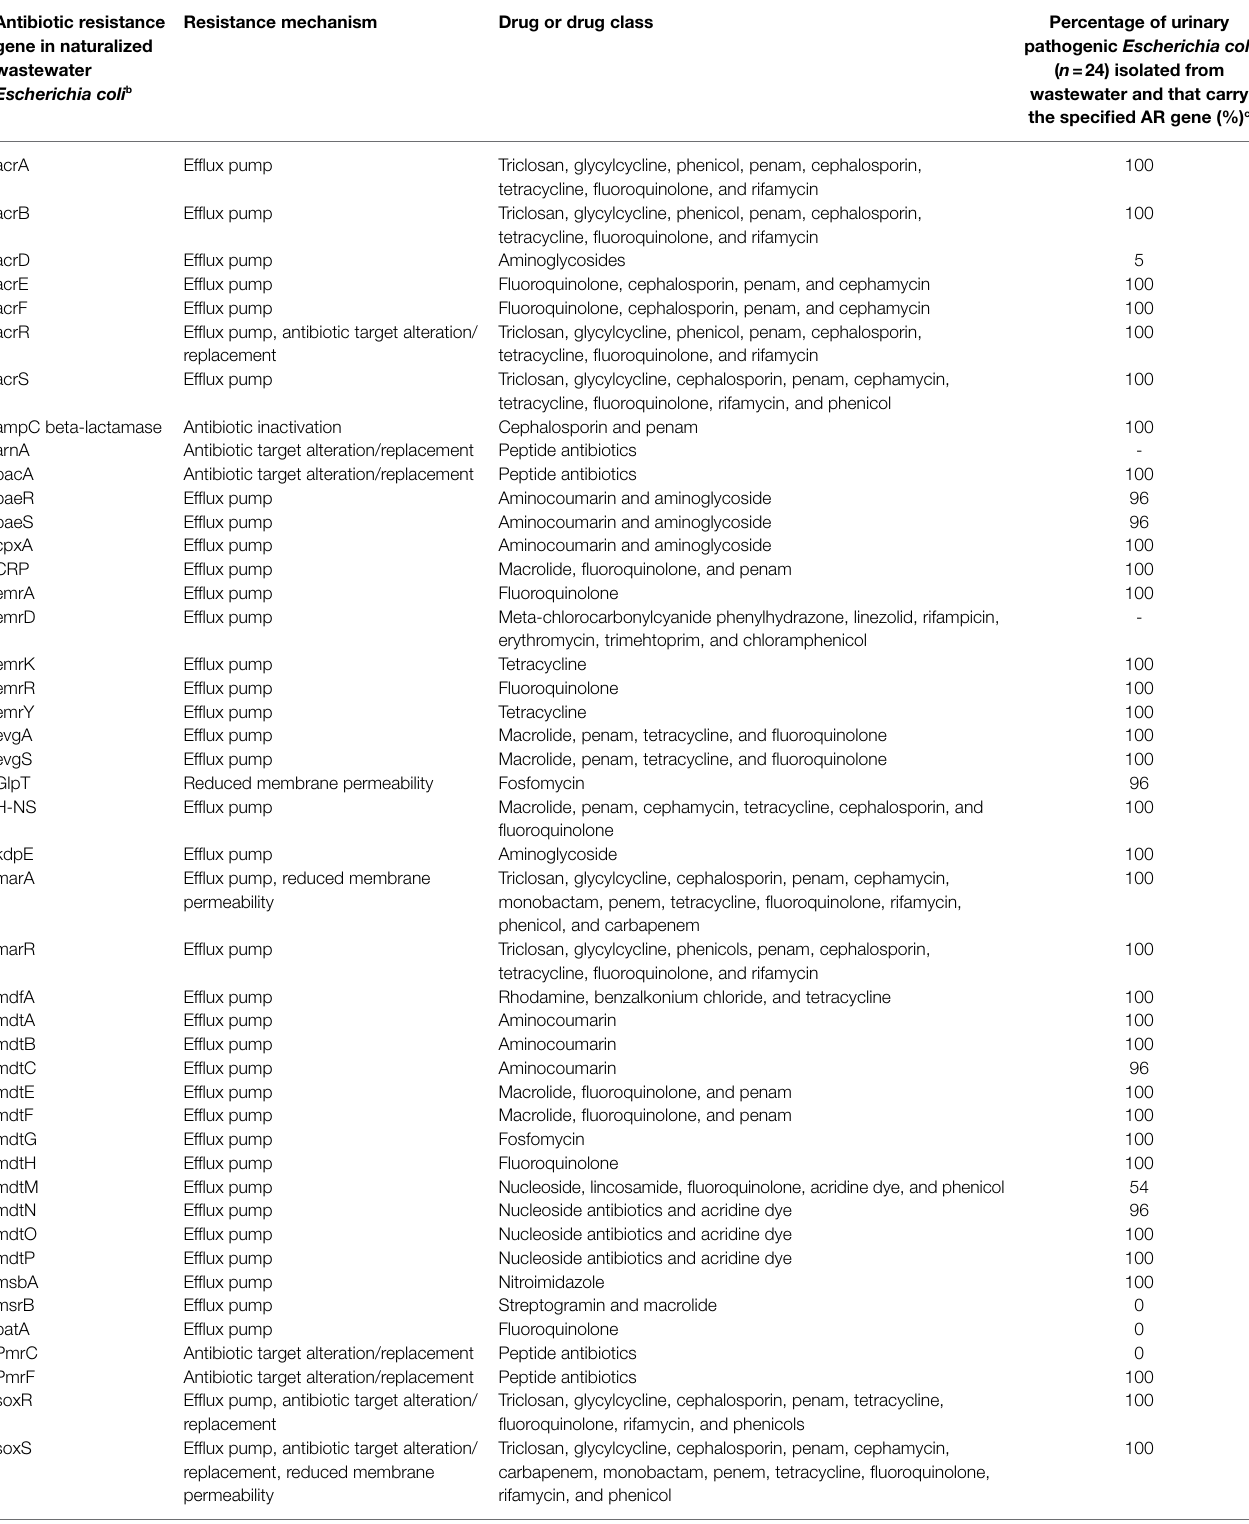
TABLE 1 | A list of the common suite of antibiotic resistance genes found in naturalized wastewater Escherichia coli strains (based on Zhi et al., 2019) implicating their importance in promoting survival and resistance to wastewater treatment and a comparison of the carriage of these genes in water treatment resistant extra-intestinal pathogenic Escherichia coli isolated from wastewater (based on Zhi et al., 2020). a Antibiotic resistance gene in naturalized wastewater Escherichia coli